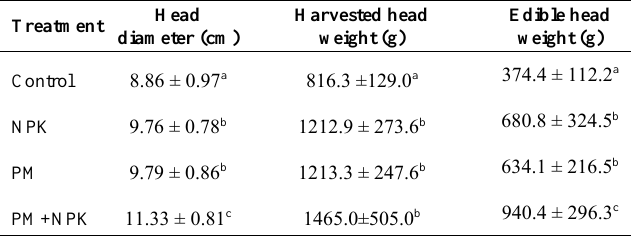
Table 1 : Effect of inorganic and organic fertilizers on the head diameter, harvested head weight (g) and the edible head weight (g) of cabbage